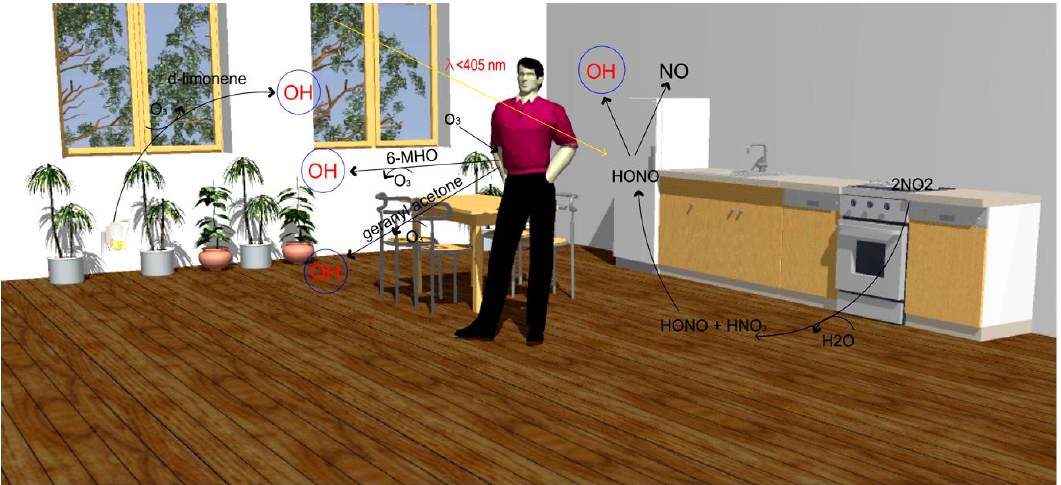
Figure 1. Schematic illustration of the important formation pathways of OH radicals indoors. Reproduced with permission from [118].